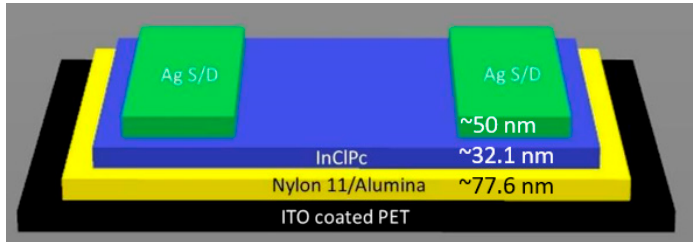
Figure 2. Organic field-effect transistor (OFET) after deposition in a bottom-gate/top-contact structure: (i) Ag source and drain dots at the top, (ii) InClPc, (iii) Nylon 11-Al 2 O 3 , and (iv) indium–tin oxide (ITO)-coated poly(ethylene terephthalate) (PET).